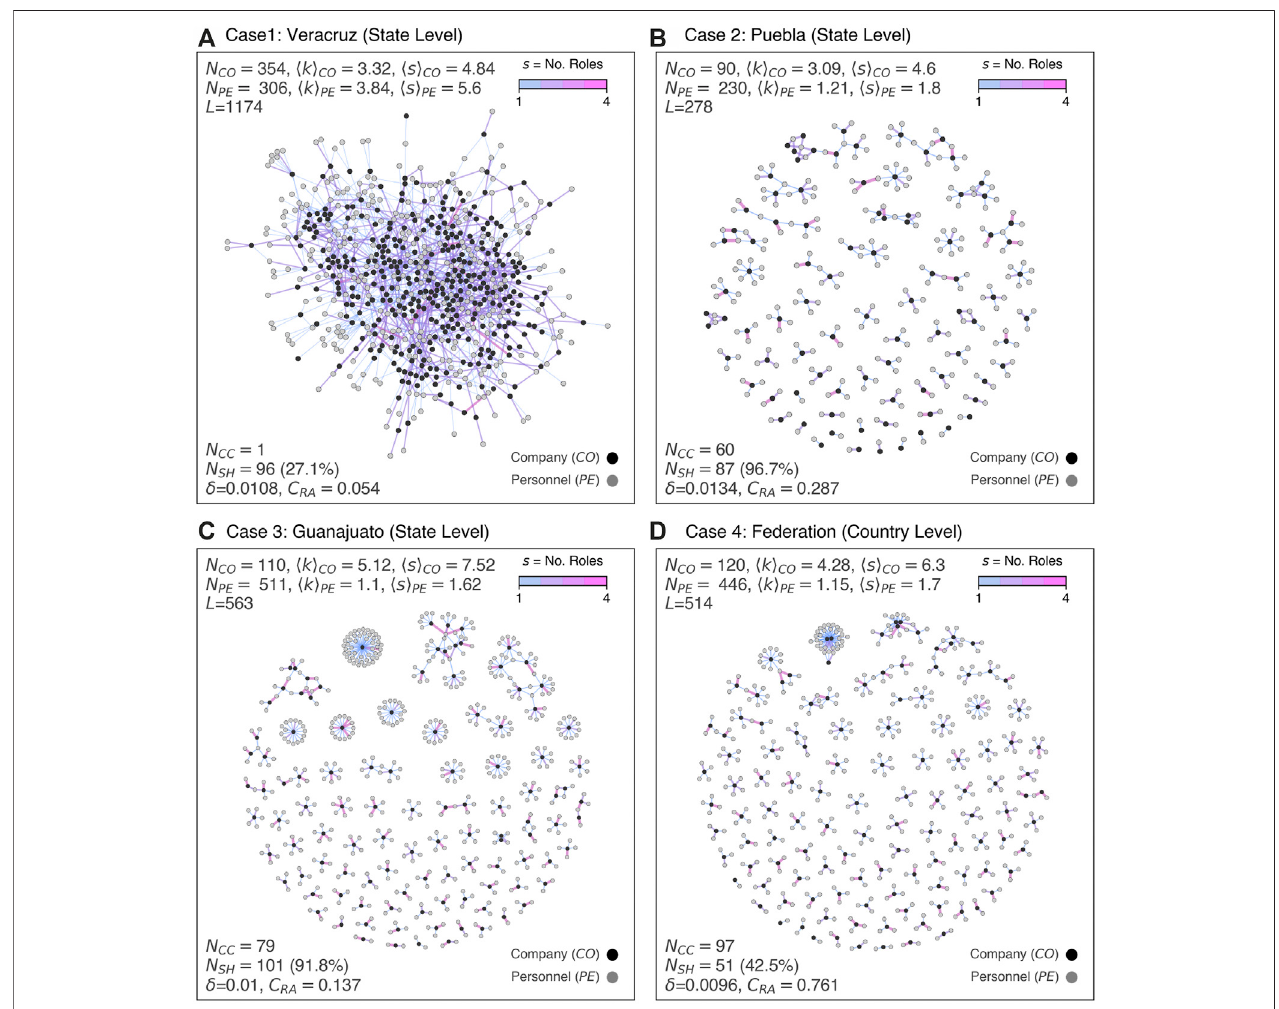
FIGURE 3 | Network visualizations and metrics. For each case (A – D) , we indicate the number of company nodes, N CO ; the number of personnel nodes, N PE ; the meandegreeofcompanyandpersonnelnodes, 〈 k 〉 CO and 〈 k 〉 PE ,respectively;themeanstrengthofcompanyandpersonnelnodes, 〈 s 〉 CO and 〈 s 〉 PE ,respectively;the numberofedges, L ;thenumberofconnectedcomponents, N CC ;thenumberofshellcompanies, N SH ;thedensity, δ ;andtheclusteringcoef fi cientofRobins – Alexander, C RA . The colorbar is related to the strength of the